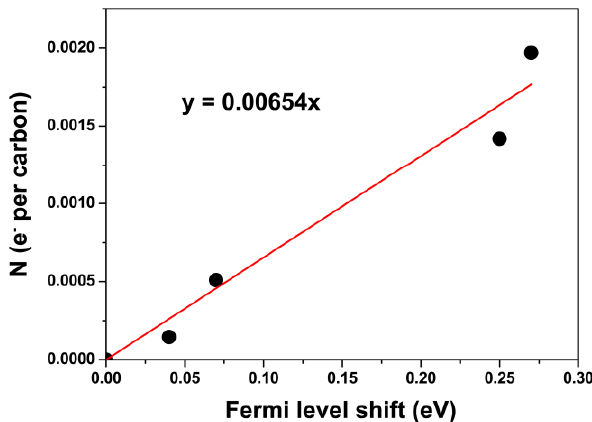
Figure 8 . The calibration plot for potassium. The data are from Ref. [195] are plotted. Figure 8. The calibration plot for potassium. The data are from Ref. [195] are